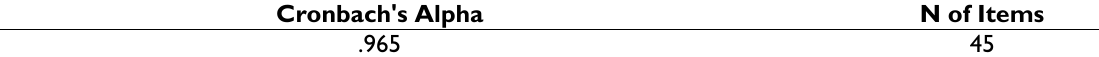
Table 4. Pearson Correlation Validity Statistics and Reliability Statistics Variable